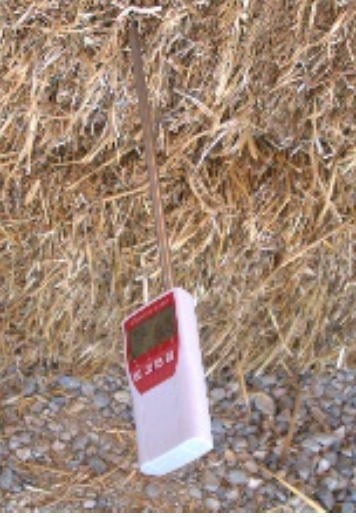
Figure 2. A straw hygrometer used to control humidity during construction. The moisture content of each straw bale is recorded.